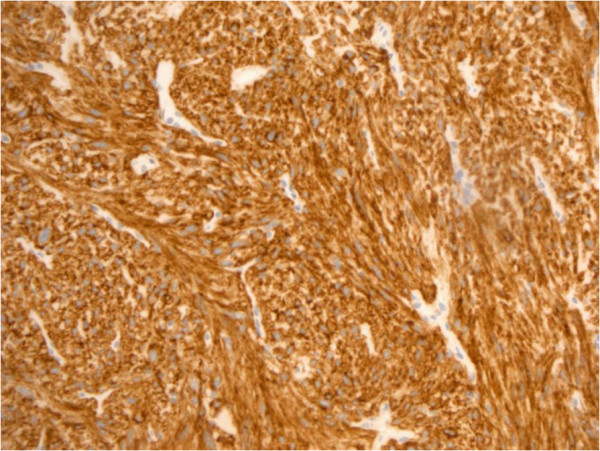
Immunostain for c-KIT: strong and diffuse cytoplasmic immunoreactivity.